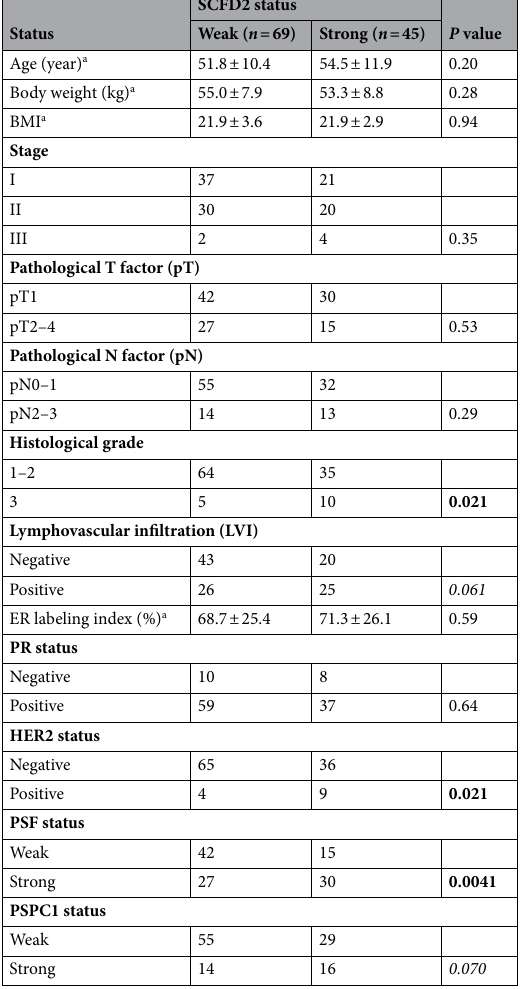
Table 3. Association between SCFD2 status and clinicopathological parameters in 114 breast cancer. P value < 0.05 and 0.05 ≤ P value < 0.10 were considered significant and borderline significant, and were listed in bold and italic, respectively. a Data are presented as mean ± SD. All other values represent the number of